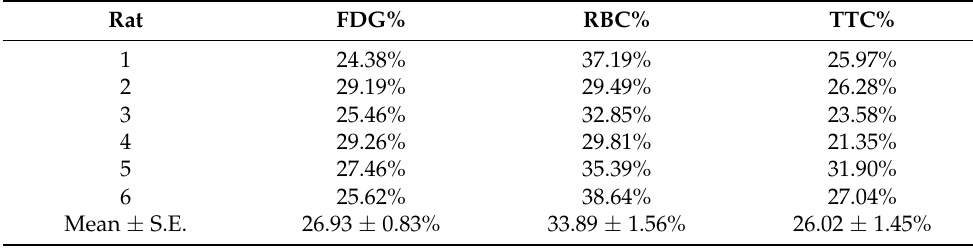
Figure 5. FDG PET and FDG RBC PET images of the LV myocardium (short axis view) from a representative myocardial infarction rat. ( a ) Metabolic FDG PET images. White triangles indicate the approximate location of decreased metabolism in the left ventricular wall. ( b ) FDG RBC PET images. White triangles indicate the approximate location of relative decreased myocardial perfusion/vascularity. Total rats = 6. Table 1. Results of mean infarction size measurement based on FDG RBC PET images, FDG PET images, and TTC pathology